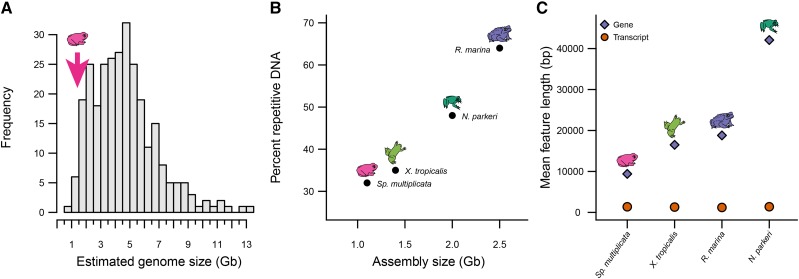
Factors contributing to anuran genome size differences. a Estimated genome sizes (Supplementary Note 1) among 284 species of anurans (Gregory 2018); arrow, estimated genome size of Spea from densitometry. b Assembly size and c gene and transcript lengths of Sp. multiplicata compared to three other sequenced, diploid anurans.